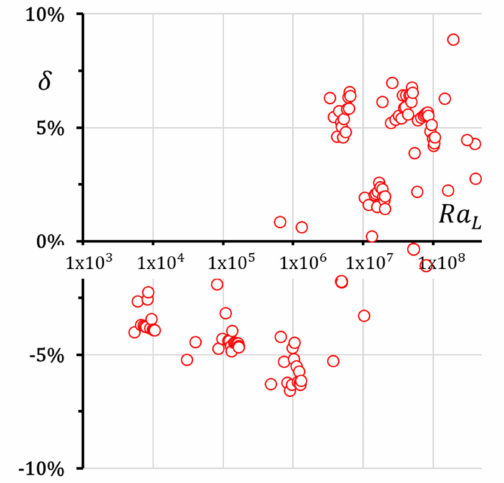
(cid:0) (cid:1) (cid:1) (cid:0) (cid:1) − (cid:0) Nu Nu L Nu L / . L ( 9 ) s s